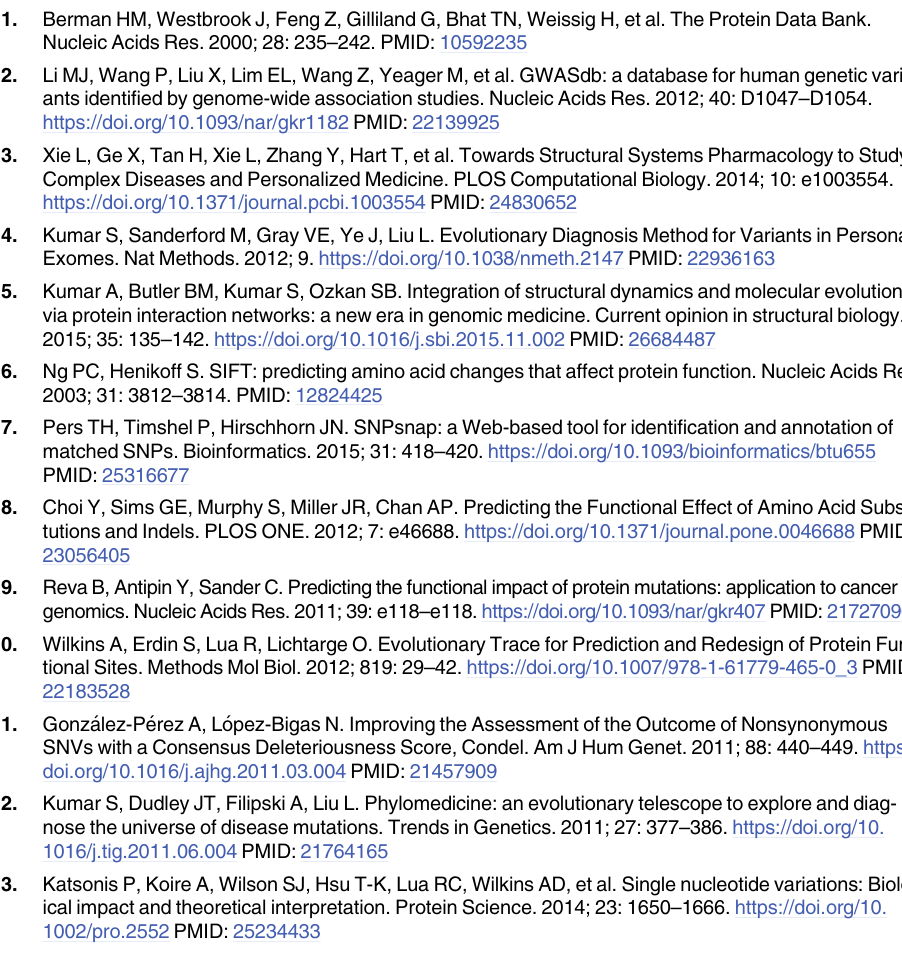
S2 Table. List of proteins without a known structure with disease related nSNVs used for prediction. Seq-GNM predictions by using a set of 323 nSNVs without a known 3D structure from 22 proteins. The protein identifiers, residue numbers, amino acid substitutions Seq- GNM scores, Seq-GNM predictions, and ground truth are